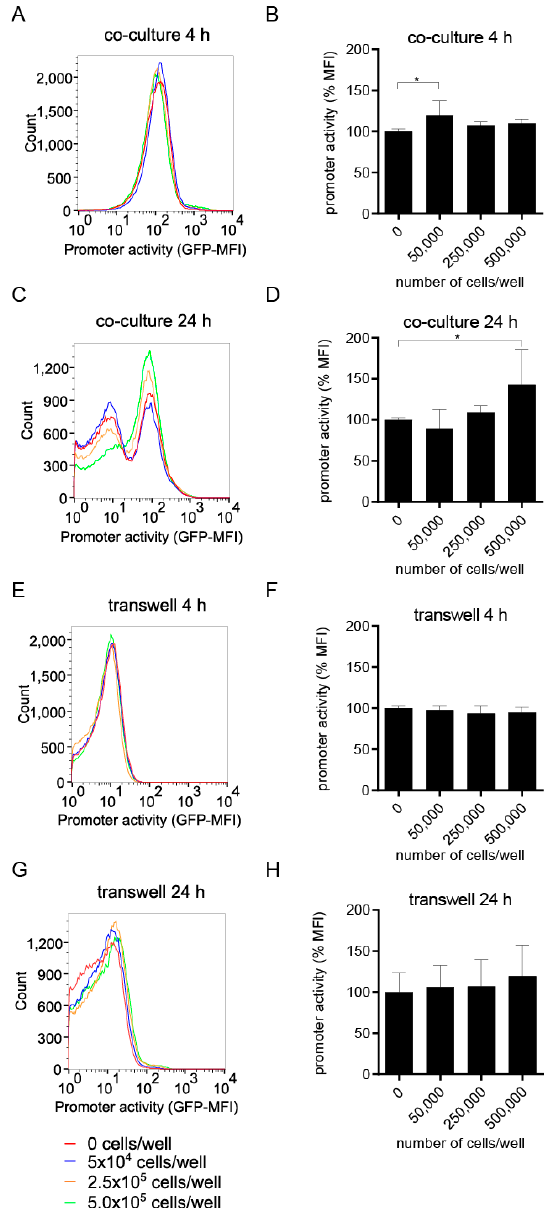
plates, seeding bacteria in the top, and havingT24/83 cells in the lower chamber. The re- porter was not or only slightly induced without statistical significance after 4 (Figure 1E,F) or 24 h (Figure 1G,H) of culture, respectively. This indicated that a contact of CFT073 and the epithelial cell line was required for P2 induction.